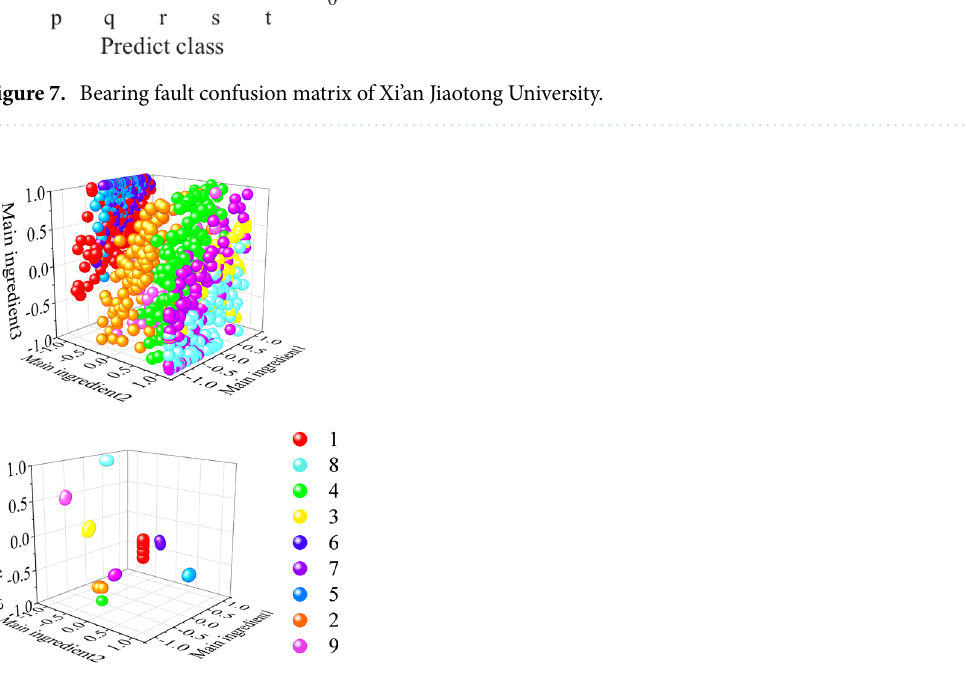
Figure 8. University of Connecticu gear failure data